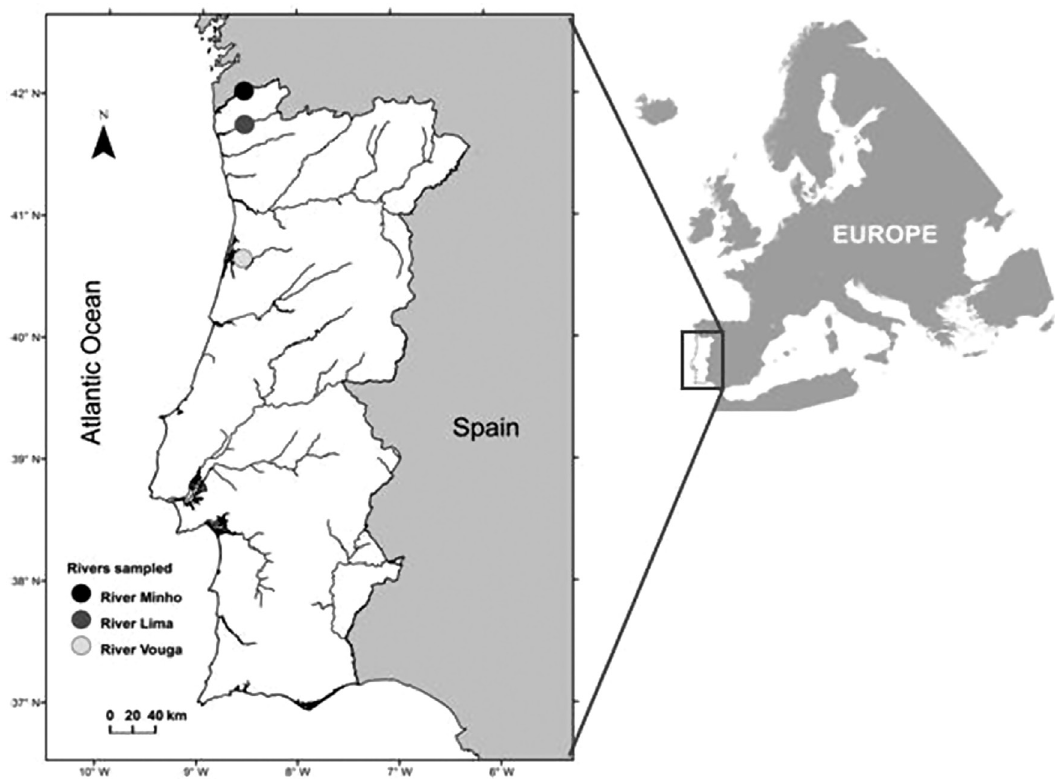
Figure 1: Geographical location of the hydrographic basins of Minho, Lima and Vouga (Portugal) where the juvenile sea lampreys were